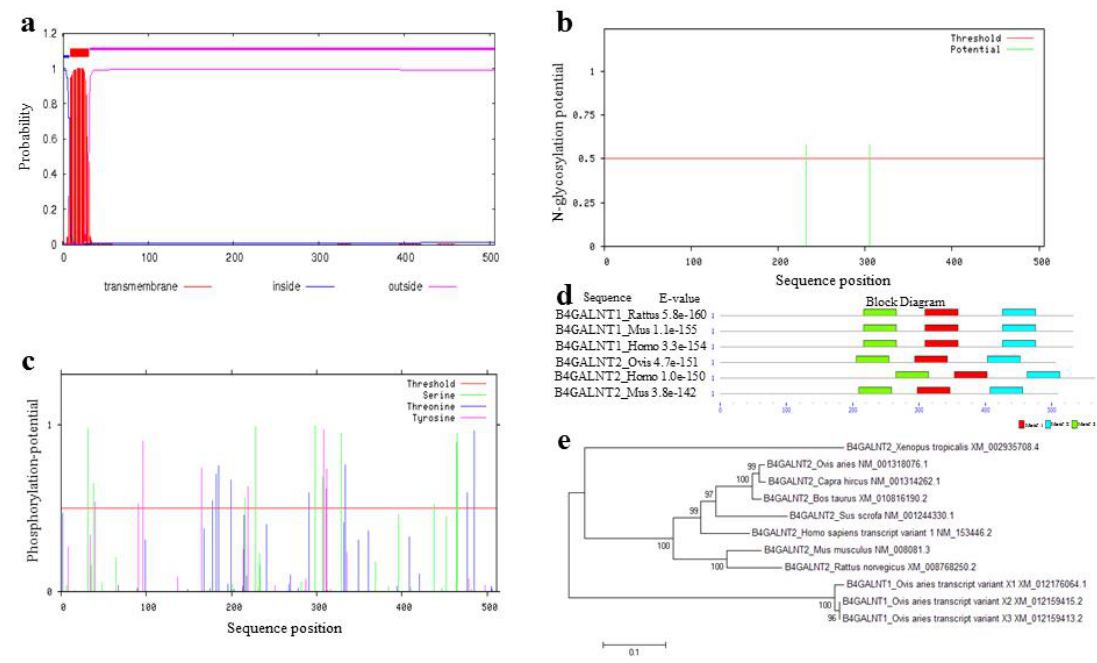
Figure 4. Amino acid sequence analysis of ovine B4GALNT2 and its multiple sequence alignments. ( a ) Predicted transmembrane helices of the B4GALNT2 protein. ( b ) Predicted N -glycosylation sites of the B4GALNT2 protein. ( c ) Predicted phosphorylation sites of the B4GALNT2 protein. ( d ) Prediction of the three most important motifs in the B4GALNT2 protein. ( e ) Phylogenetic tree based on the homology nucleotide sequence for B4GALNT2.